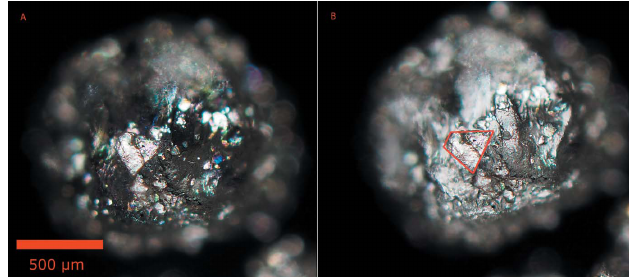
Figure 1 Optical microscopy images of a typical agglomerate particle under ( a ) cross- and ( b ) parallel-polarized transmitted light, revealing outlines of single crystallites (in red).